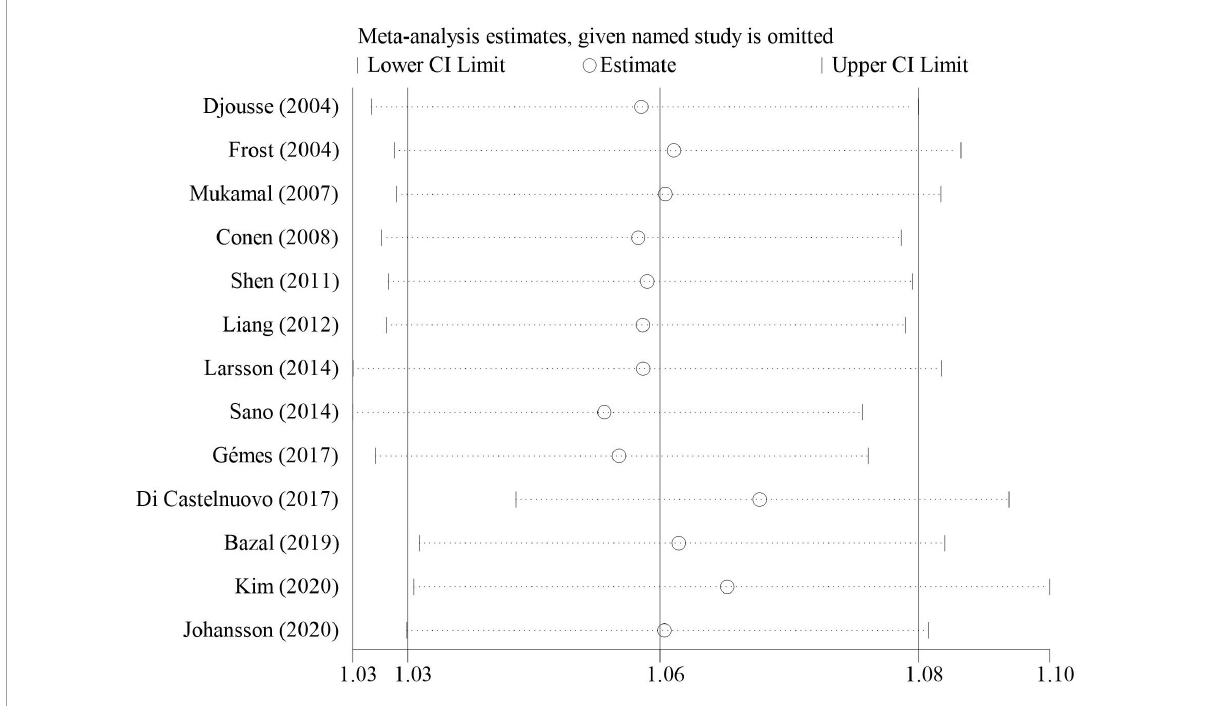
FIGURE3 Sensitivity analysis of relative risks of atrial fibrillation per 1 drink/day increment in alcohol